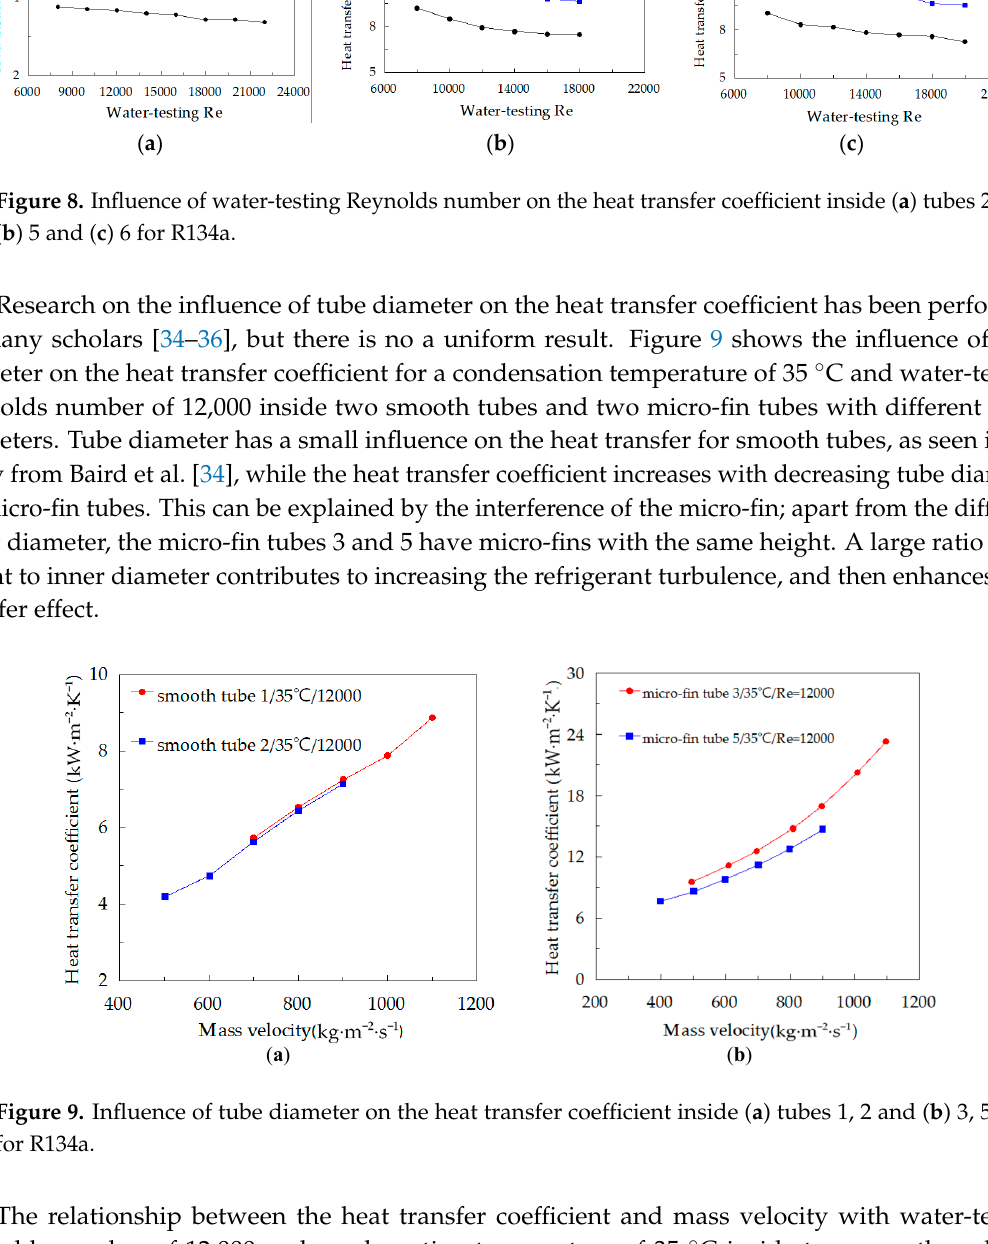
Figure 7. Influence of mass velocity and condensation temperature on the heat transfer coefficient inside ( a ) tubes 2; ( b ) 5; and ( c ) 6 for R134a.